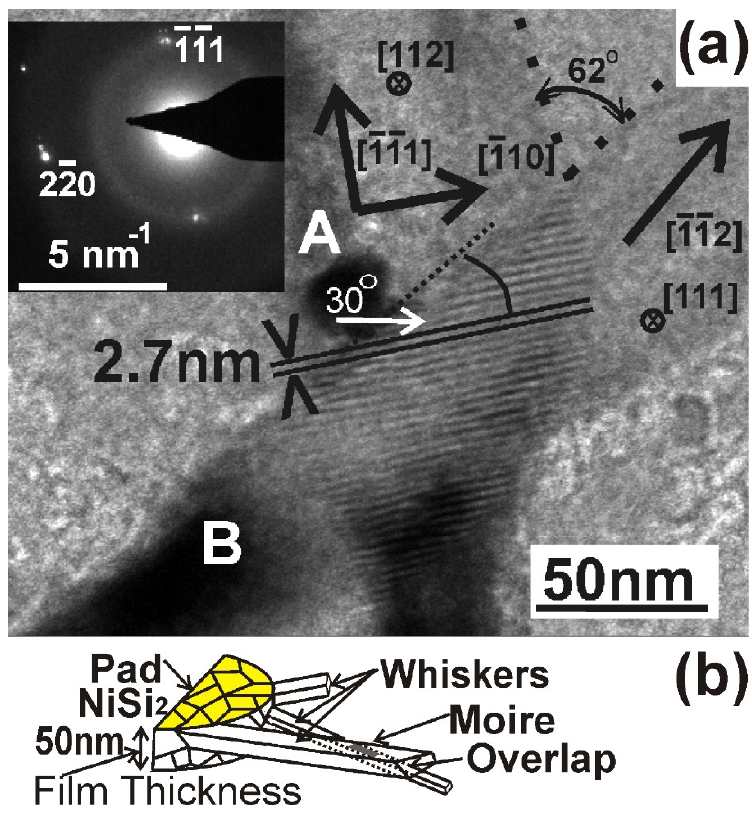
Figure 5. ( a ) High magnification TEM micrograph from the crossing area of two whiskers A and B in the inset is the corresponding diffraction pattern. The two whiskers have common reflection of 220, which is split; the Moiré fringes are perpendicular to this reflection, revealing that they are of the rotational type. ( b ) Schematic representation in 3D of two overlapping whiskers emanating from the NiSi 2 pad. The total thickness of the overlapping whiskers A and B must not exceed the thickness of the film.